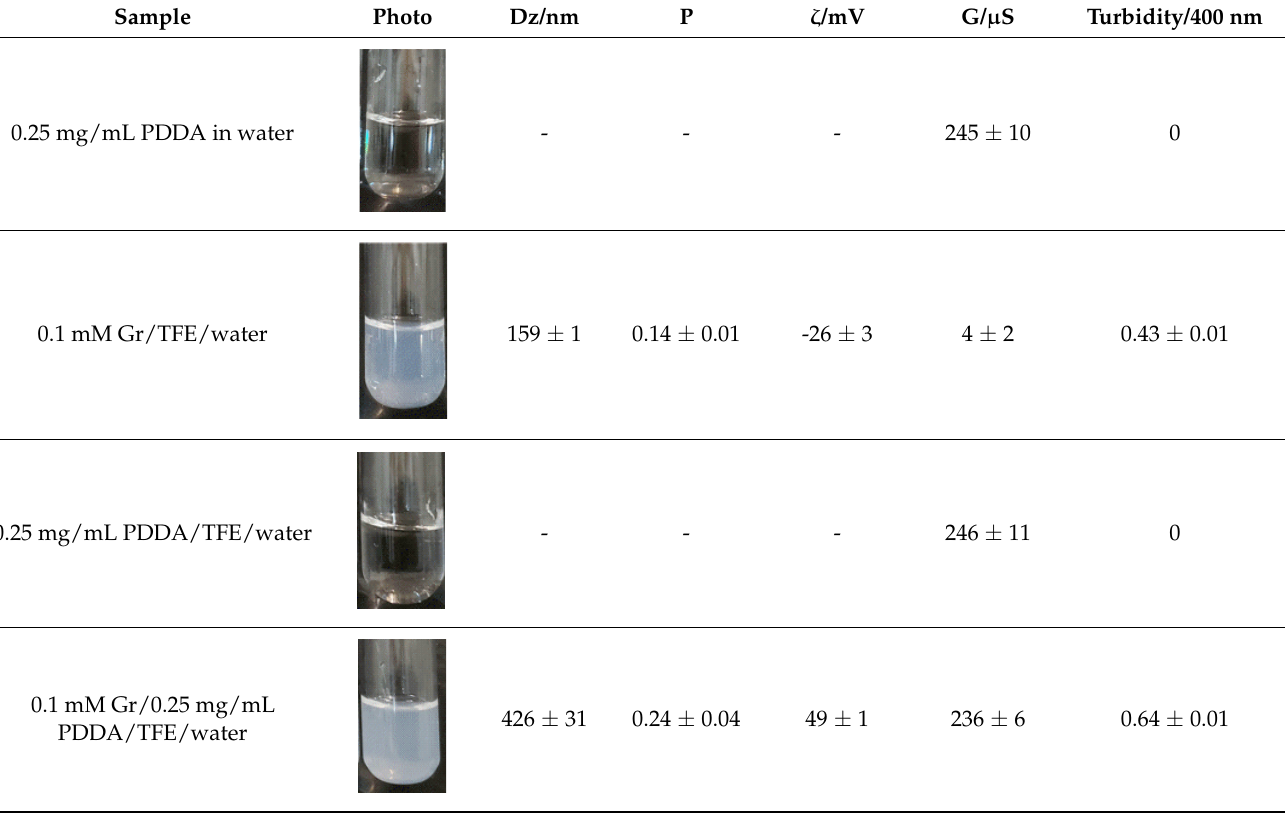
Table 1. Photos and physical properties of gramicidin (Gr) dispersions in water or in poly (dial- lyldimethyl ammonium chloride) (PDDA) water solutions. Physical properties were the mean z-average diameter (Dz), the zeta potential (ζ), the polydispersity (P), the conductance (G) , and the turbidity at 400 nm. Gr dispersions were prepared from 0.031 mL of a 6.4 mM stock Gr solution in trifluoroethanol (TFE) added under stirring to 2 mL water. Gr/PDDA dispersions were prepared by adding 0.05 mL of a stock 10 mg/mL PDDA water solution to 2 mL of the Gr NP dispersion also under stirring. G of pure water was 5 ± 1 μS and G of TFE in water was 13 ± 1 μS.